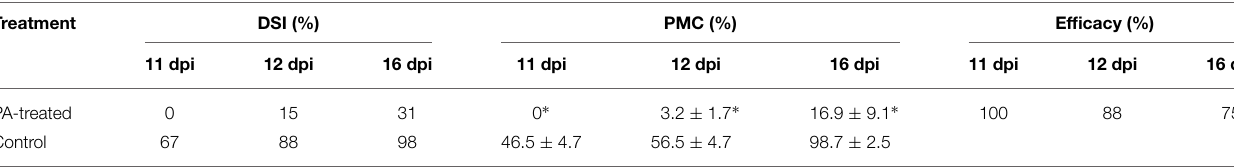
TABLE 1 | Effect of P. aphidis treatment on severity of disease symptoms caused by P. xanthii.